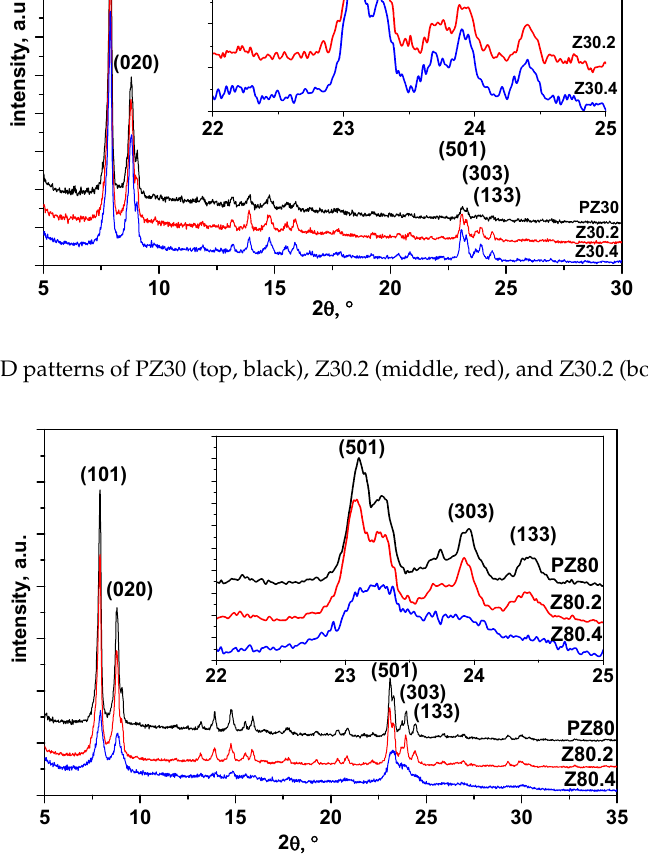
Figure 2. XRD patterns of PZ80 (top, black), Z80.2 (middle, red), and Z80.2 (bottom, blue).